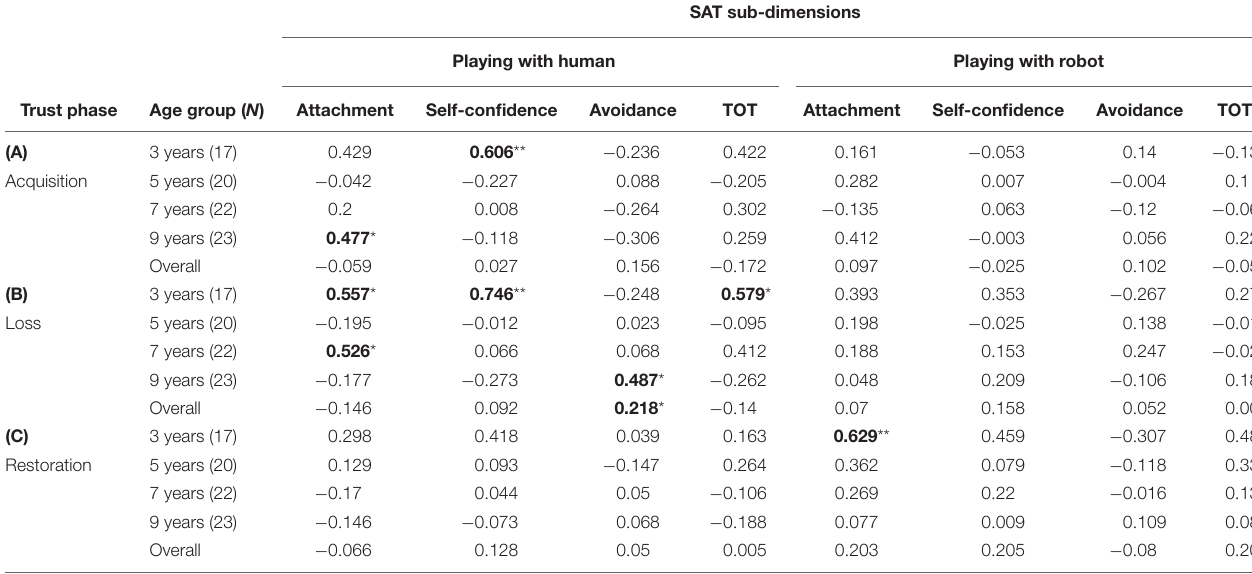
TABLE 1 | Association between Trust and SAT.